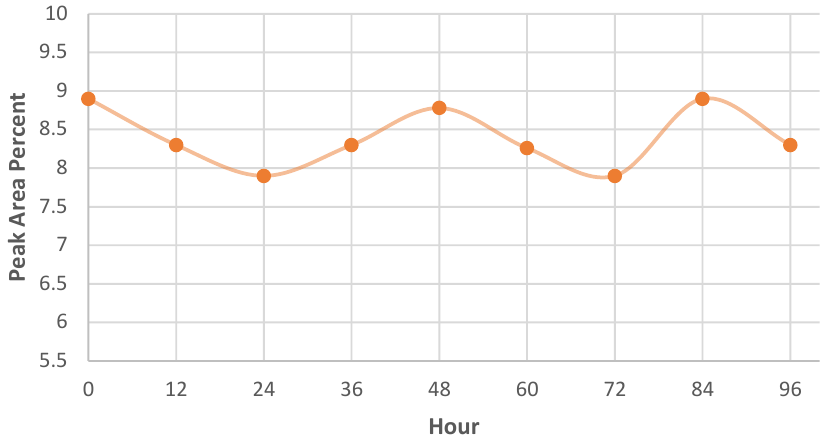
Figure 4. Peak area percent of carvone volatiles produced by the leaves of M. spicata immobilized vermiculite ball.